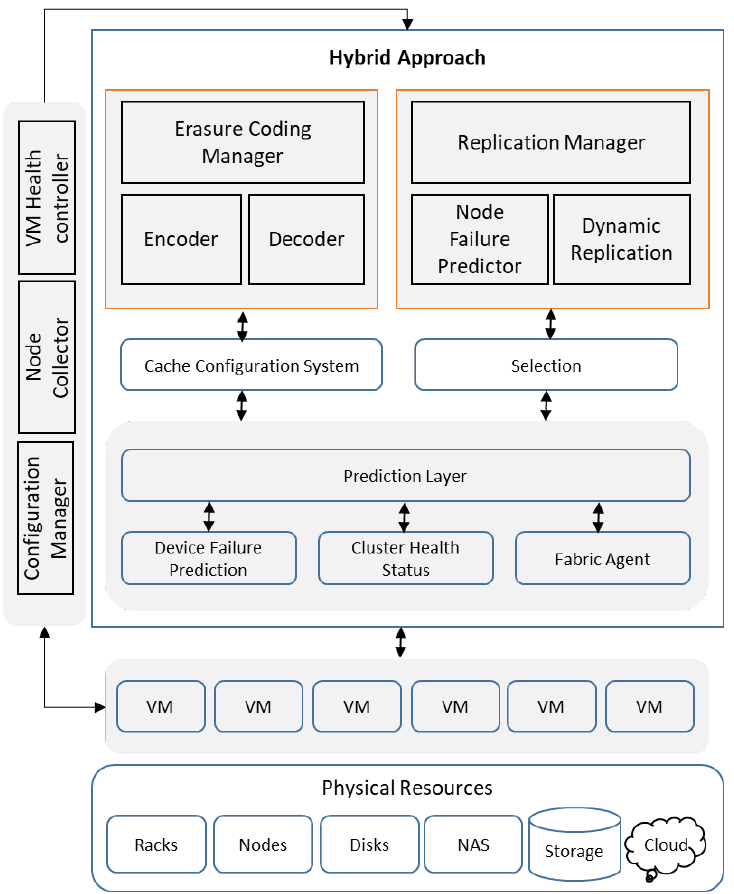
Figure 2. Conceptual description of the proposed solution.